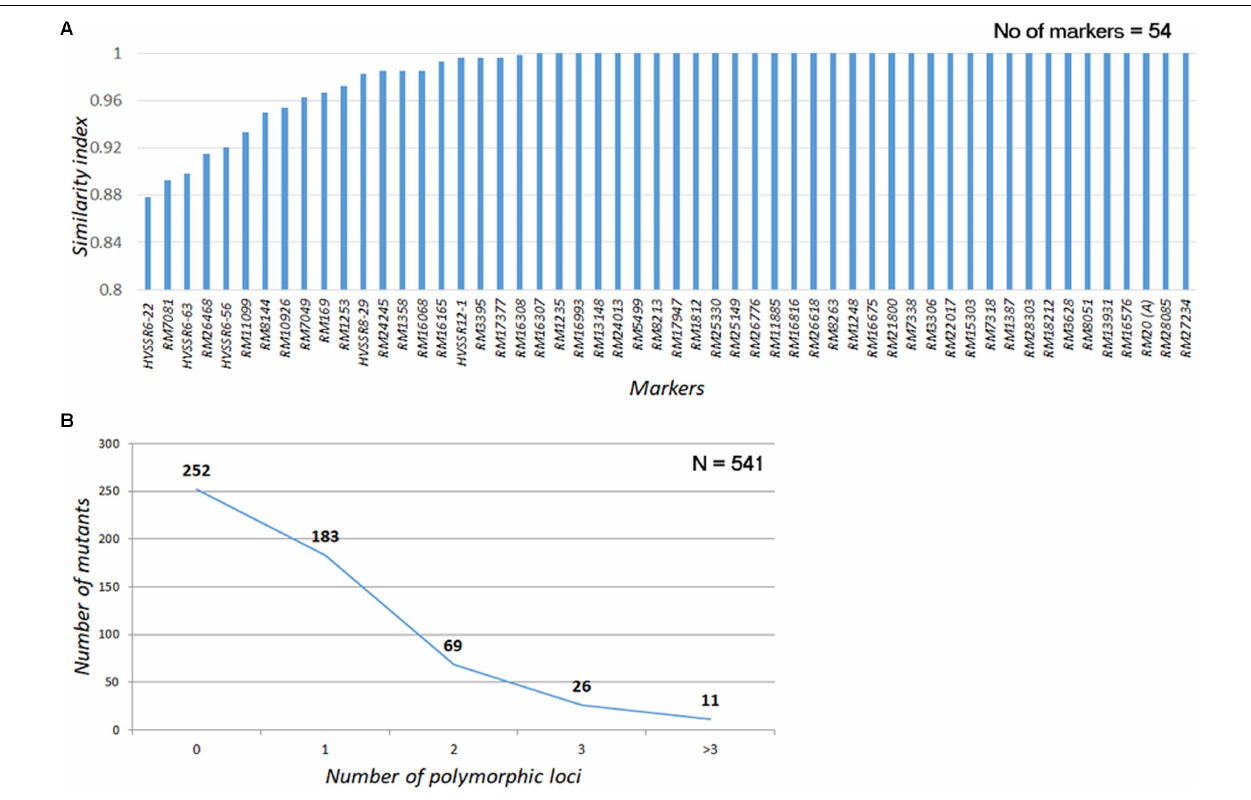
FIGURE 4 | Assessment of genomic similarity of the mutants with Nagina 22 using SSR markers (A) Similarity index of SSR markers used for genotyping the mutants; (B) Polymorphism in the mutants for SSRs. Similarity scores were assigned by comparing the PCR amplicon size of the mutant with that of WT. If they are same a score “1” was assigned; if not “0” score was assigned. The scores were averaged across all the markers to arrive at mutant similarity index. The scores were also averaged over all the mutants for each marker to arrive at trait marker performance